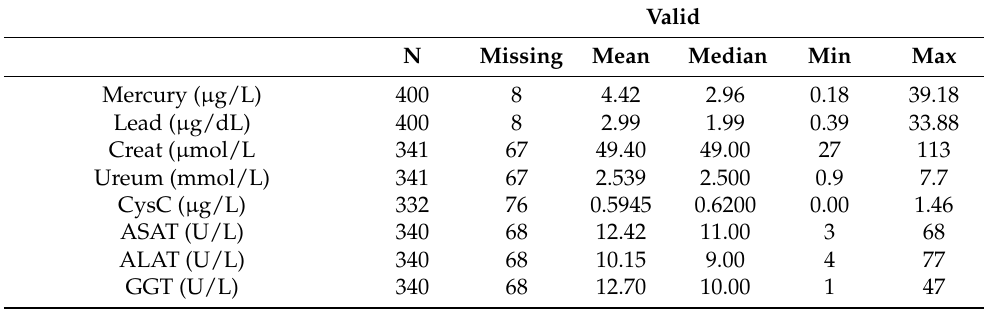
Table 2. Distribution of mercury and lead concentrations and biomarkers for liver and kidney